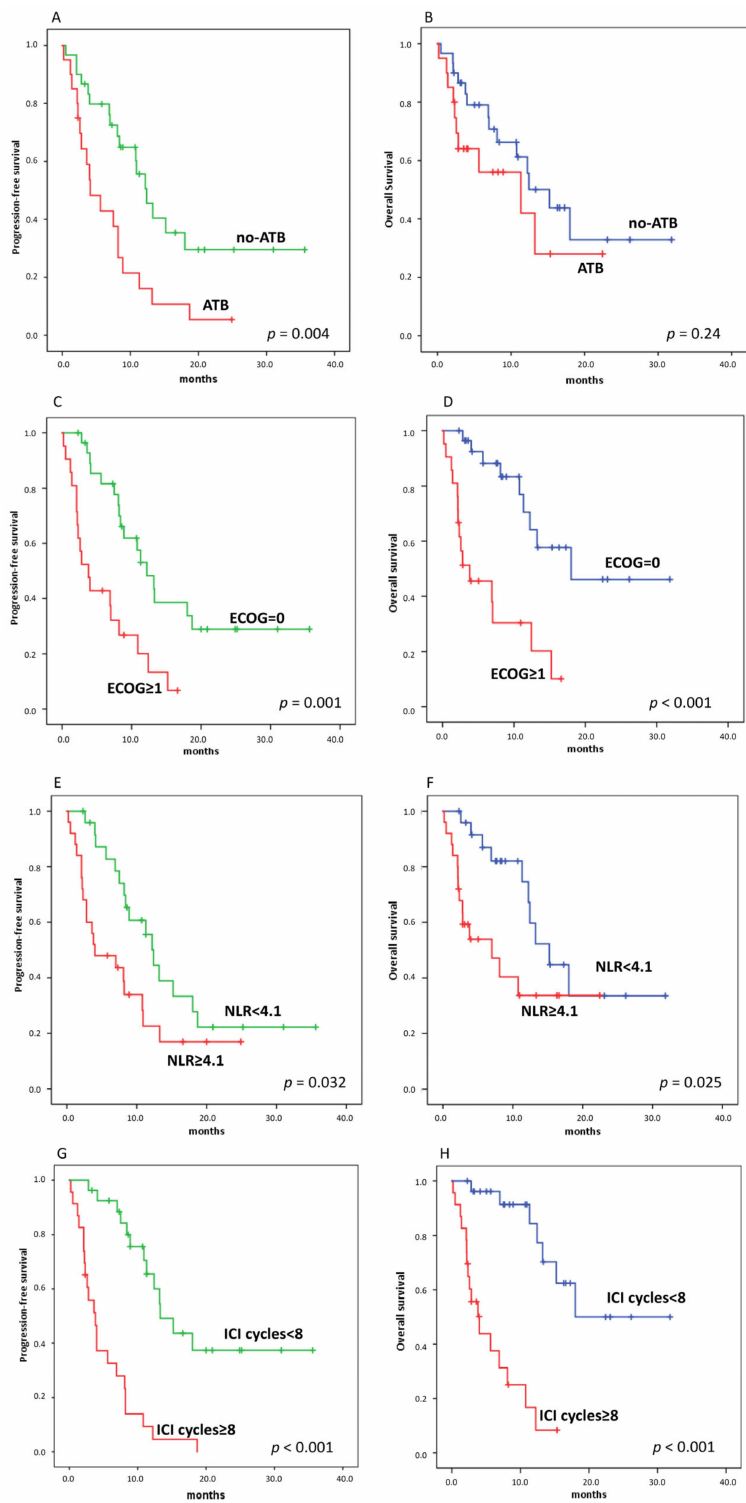
Figure 5. Kaplan–Meier curves for progression-free survival (PFS) ( A , C , E , G ) and overall survival (OS) ( B , D , F , H ), stratifying by using ATB, ECOG (Eastern Cooperative Oncology Group)performance status, NLR, and number of ICI courses, respec- tively. (( A ), 12.4 vs. 4.1 months, p = 0.004), (( B ), 11.3 vs. 15.3 months, p = 0.24); (( C ), 12.2 vs. 3.8 months, p = 0.001), (( D ), 18.8 vs. 3.8 months, p < 0.001); ((E), 12.4 vs. 4 months, p = 0.001), (( F ), 15.2 vs. 7 months, p < 0.025); (( G ), 3.8 vs. 13.3 months, p < 0.001), (( H ), 4 vs. 18 months, p <